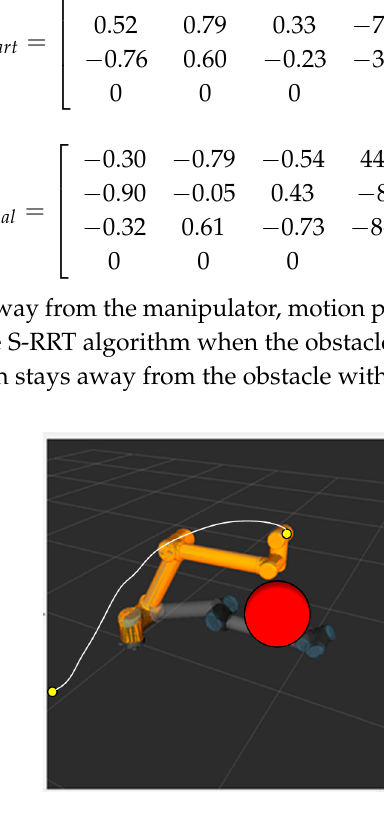
Figure 4. Replanned path after dynamic obstacle is moved.